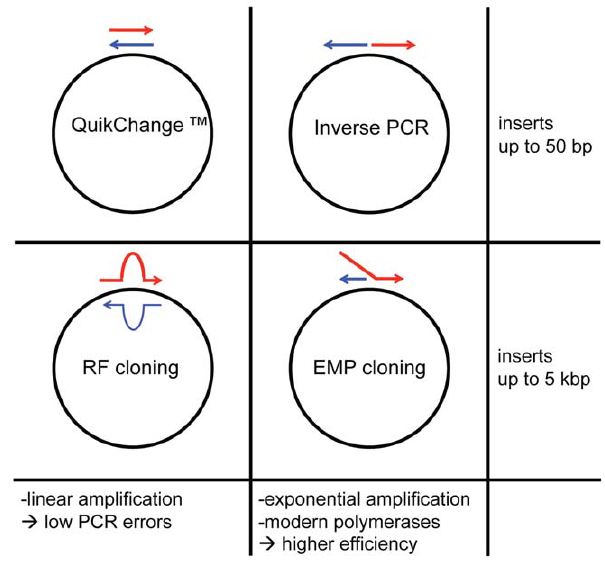
Figure 2. Analogy between PCR-based cloning techniques. QuikChange and inverse PCR allow insertion of up to 50 bp, whereas RF and EMP cloning can accommodate inserts of up to 5 kb. QuikChange and RF cloning use linear amplification to obtain their product. This causes few PCR errors since potential mutations cannot be inherited in the next PCR cycle but also causes low product amounts. Inverse PCR and EMP cloning utilize exponential amplification to obtain high product amounts resulting in intensive, easily observable product bands, and large colony numbers.